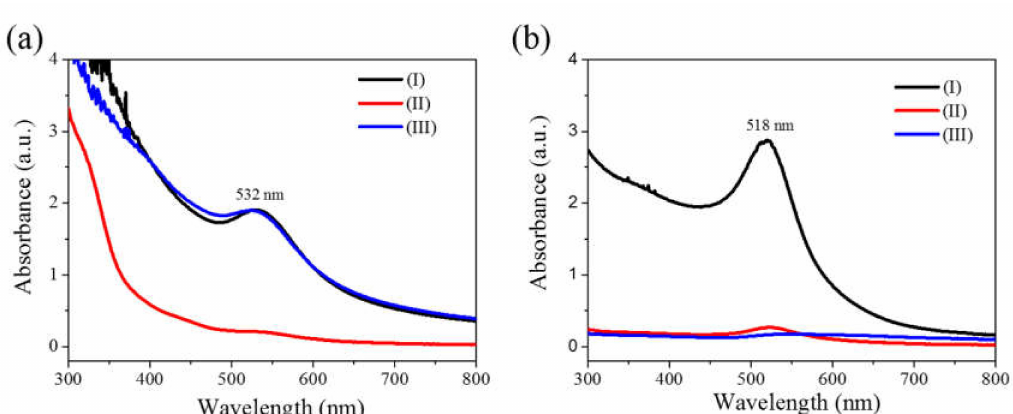
Figure 1. Absorption spectra of gold nanoparticles (AuNPs) fabricated using ( a ) green method and ( b ) standard (conventional) method with sodium citrate as the reducing agent. Spectra I, II, and